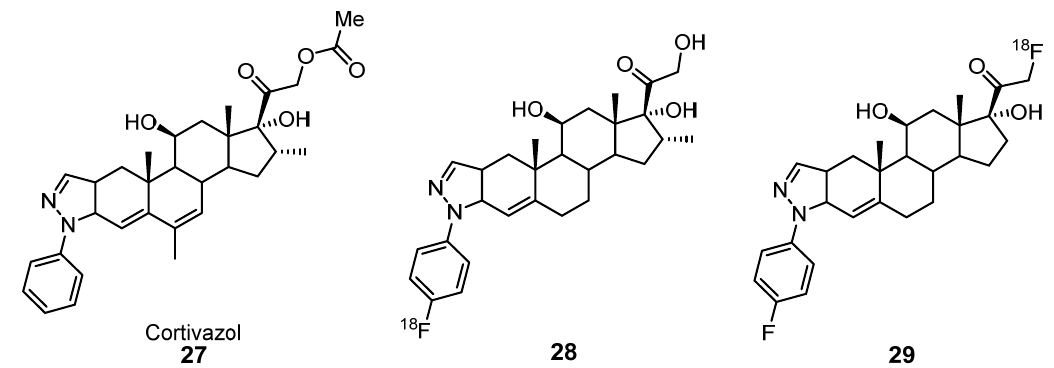
Figure 11. Cortivazol ( 27 ) and related [ 18 F]arylpyrazolo steroids 28 – 29 as potential glucocorticoid receptor ligands for PET imaging [54,55].